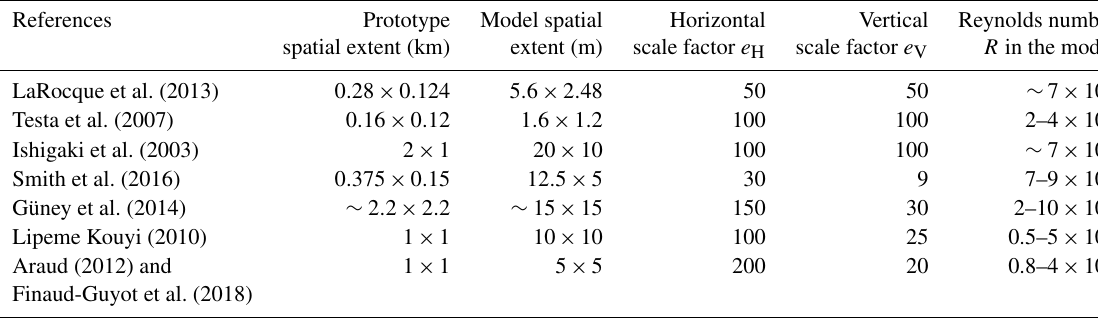
Table 1. Recent laboratory experiments of urban flooding at the district